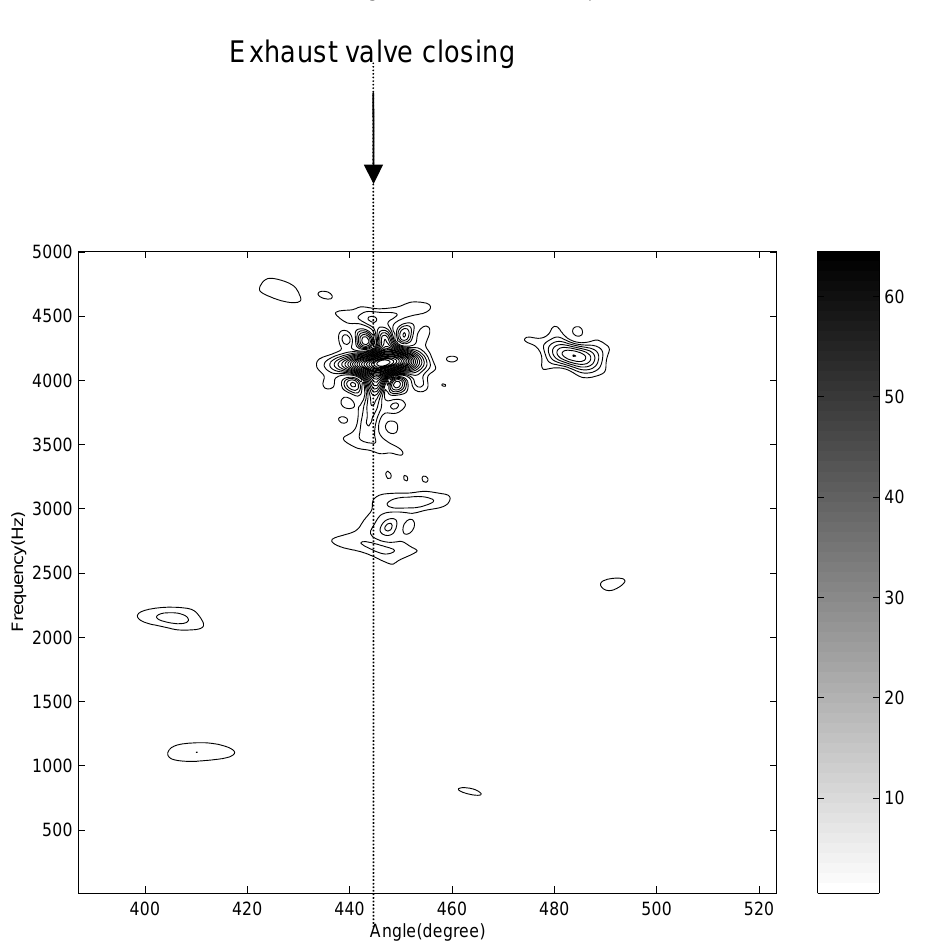
Fig. 8. Sliced Wigner forth order moment spectra smoothed by the γ -method for the enhanced signal after two stage